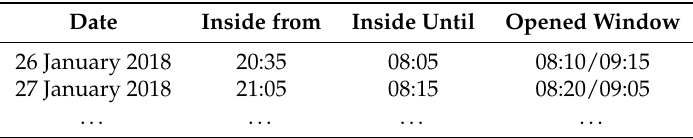
Table 6. New knowledge creation for bedoom